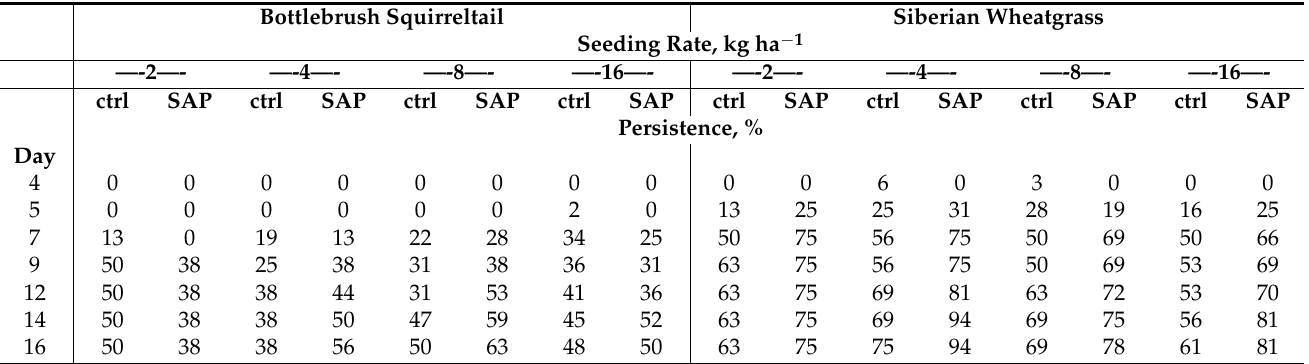
Table A2. Persistence (percent of seedlings alive) for bottlebrush squirreltail and Siberian wheatgrass grown in treatments with and without superabsorbent polymer (SAP) at seeding rates of 2, 4, 8, or 16 kg ha − 1 (1/4, 1/2, 1, or 2 times the NRCS recommended seeding rates). All treatments were watered once to saturation and allowed to dry